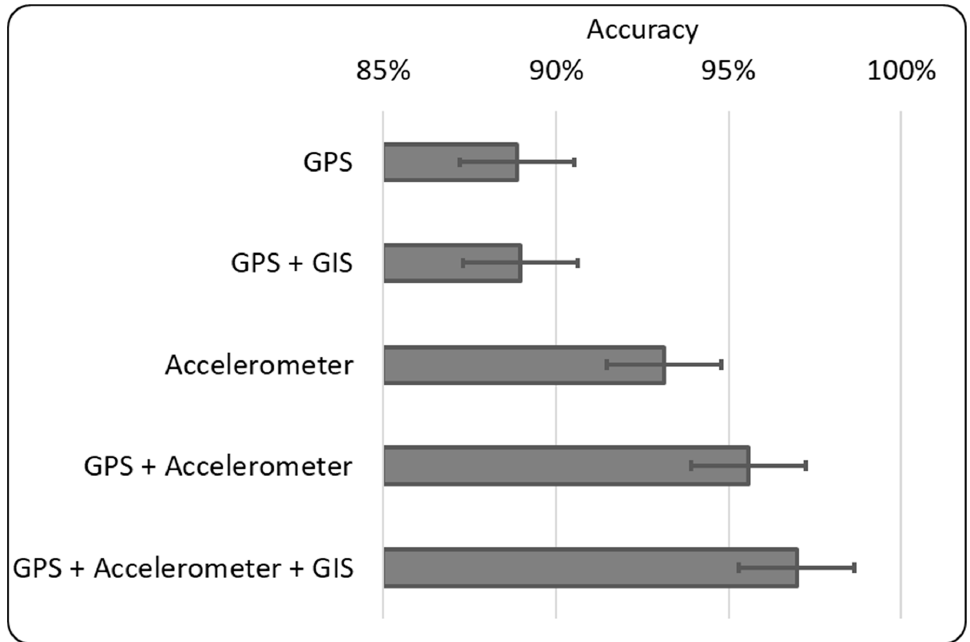
Figure 2. Evaluation results on different combinations of sensor data vs. accuracy.